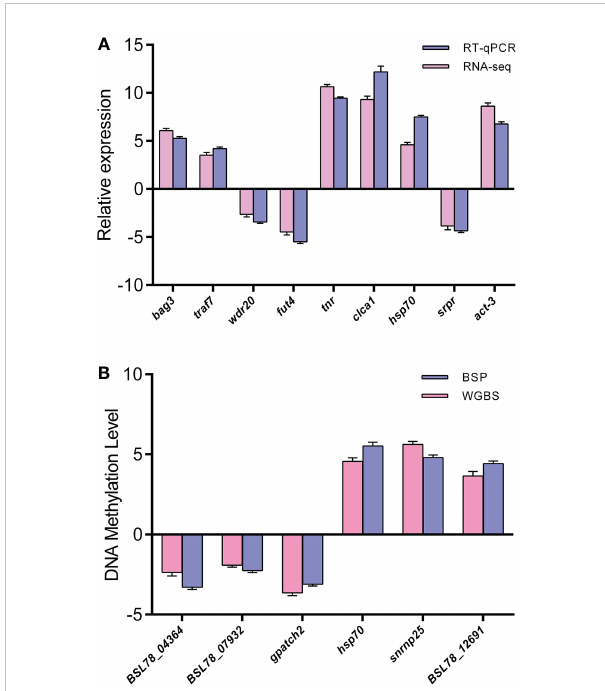
FIGURE 6 (A) Comparison of mRNA expression levels among the nine DEGs obtained using qRT-PCR validation. Log2Fold Change are expressed as the ratio of gene expression after normalization to Actb . (B) Comparison of DNA methylation levels among the six DMGs obtained using BSP